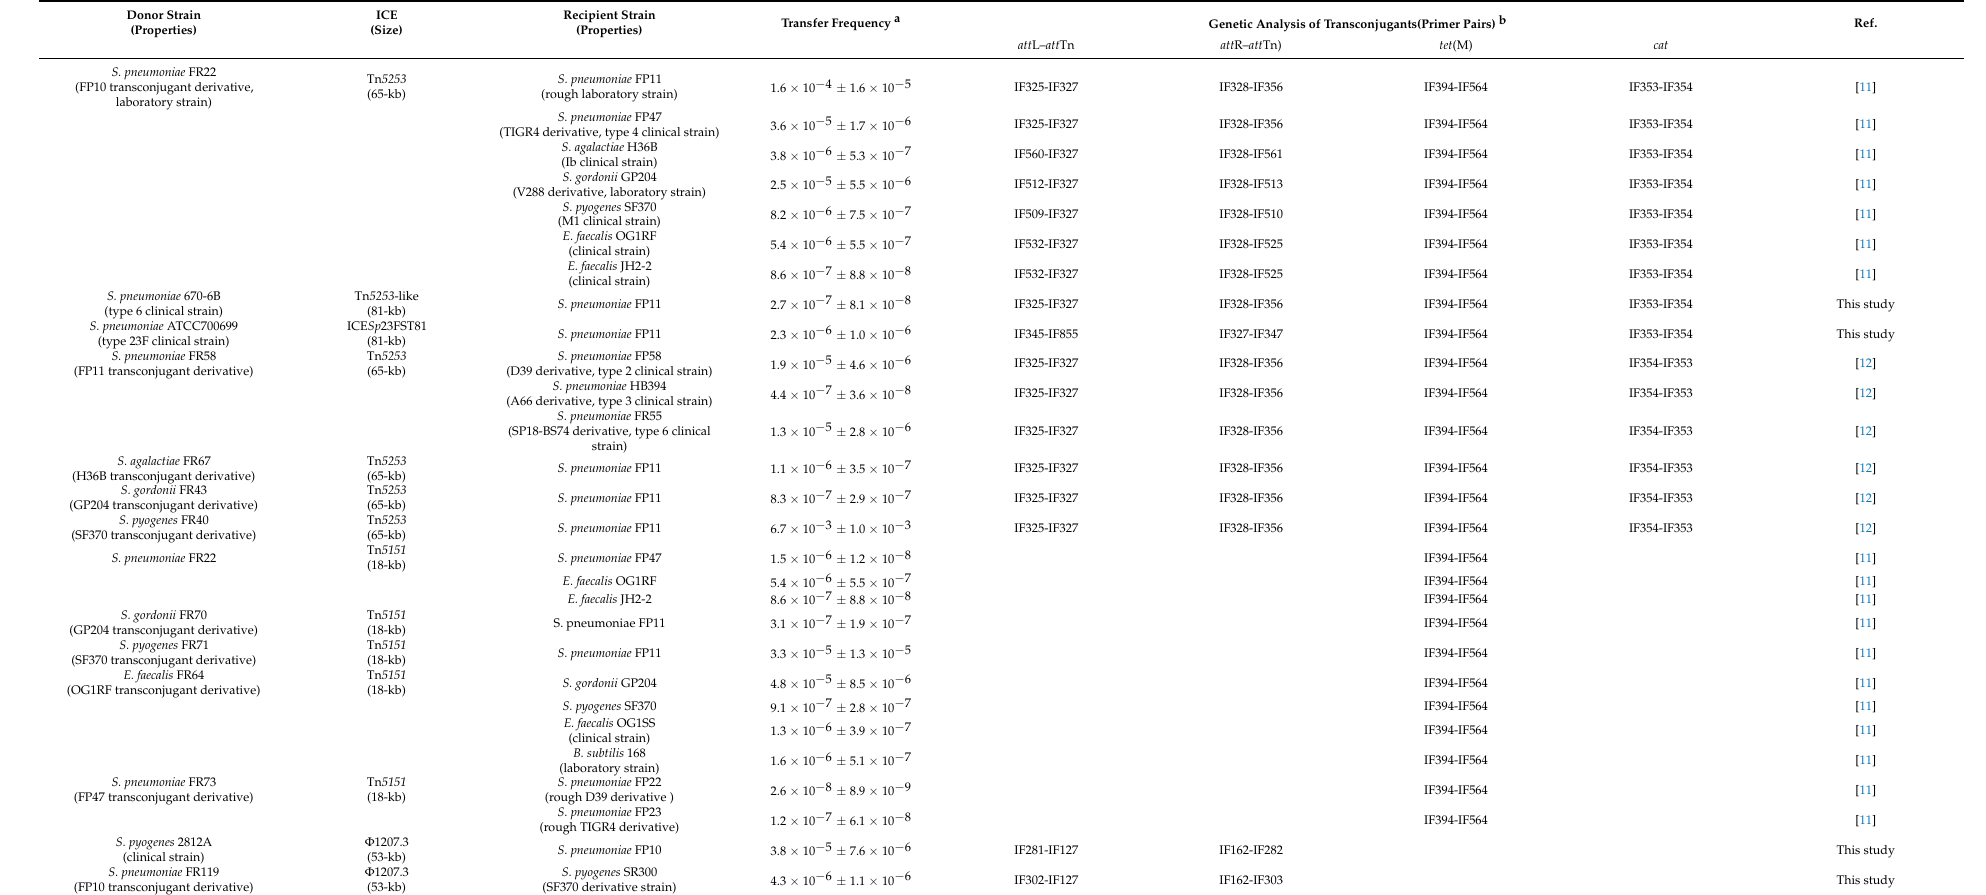
Table 1. ICEs conjugal transfer frequencies obtained with the plate mating protocol in streptococci and